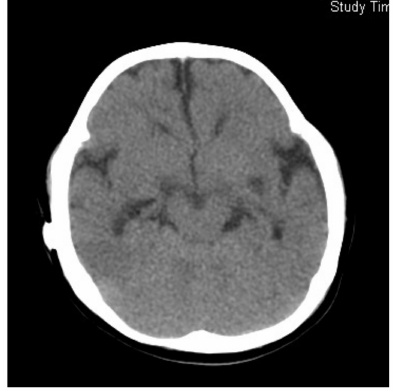
Figure 3. Brain CT of Case 2 at 12 months of age, 7 months after starting betaine